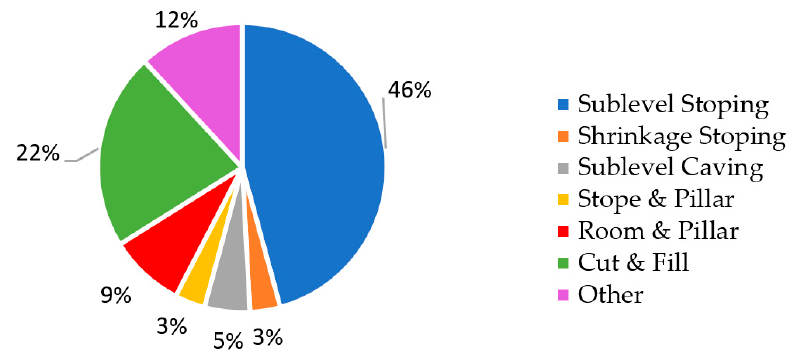
Figure 2. Applied mining methods at mines participating in the survey.